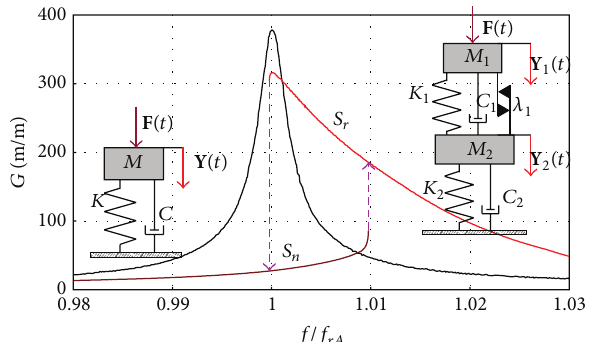
Figure 27: The effect of a crack on the 1st mode characteristics shape (steel blade, 𝑎 = 19.62 m/s 2 , 𝑓 𝑟𝐴 : frequency of amplitude resonance) [23].